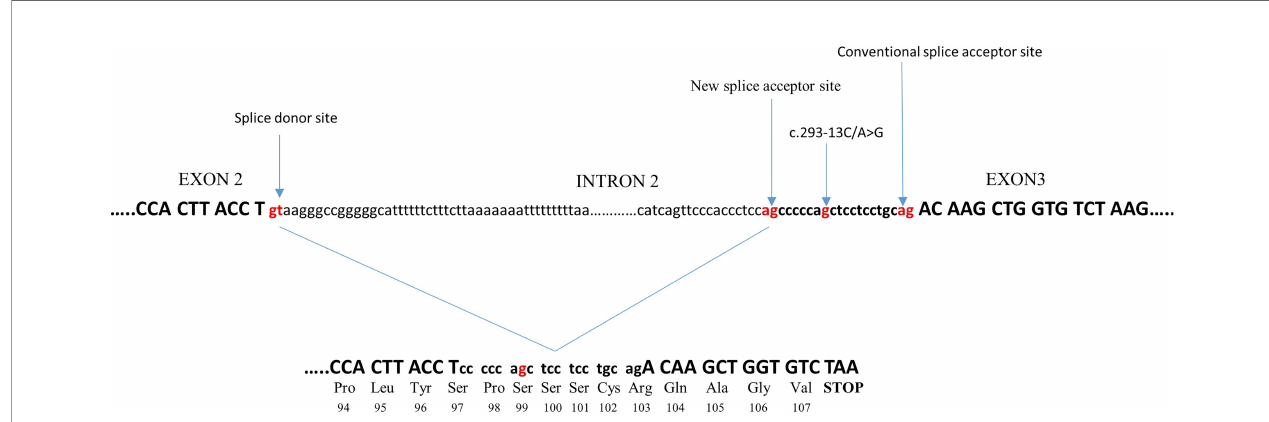
FIGURE 1 | Effect of the c.293-13C/A>G variant on splicing. The c.293-13C/A>G variant, at a − 13 position before the end of intron 2, creates an additional splice acceptor site, causing aberrant splicing of intron 2 with retention of 19 intronic nucleotides. This causes a frameshift in the following third exon to generate a stop codon after 107 amino acids, resulting in the production of a truncated protein.